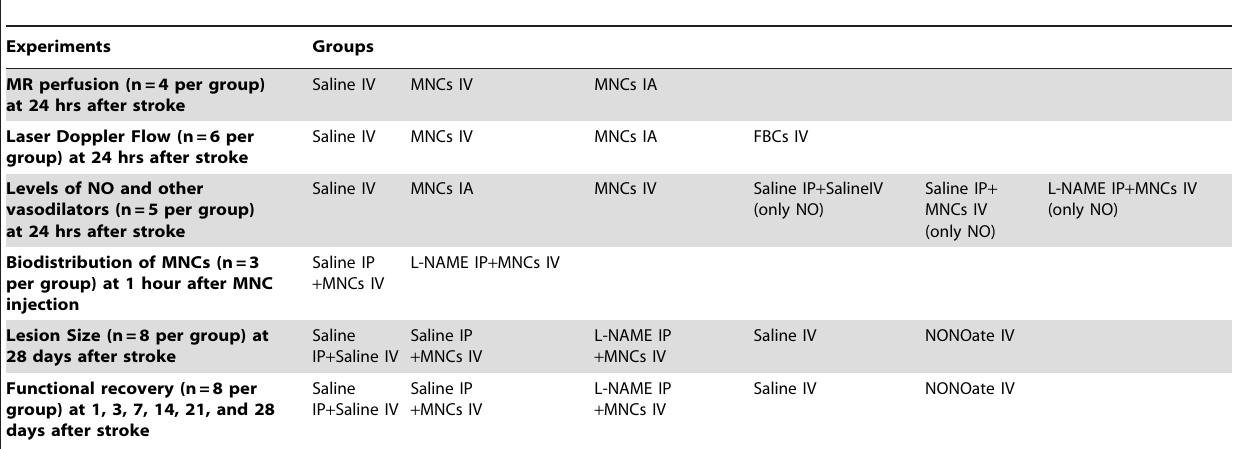
Table 1. Experimental